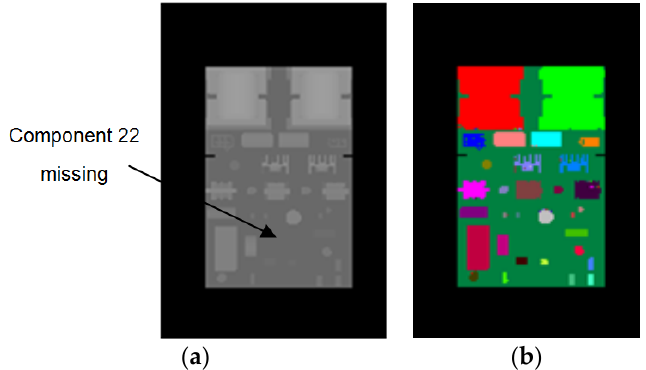
Figure 11. PCB with component 22 missing. ( a ) Synthetic depth image. ( b ) The resulting pixel classification image of ( a ).